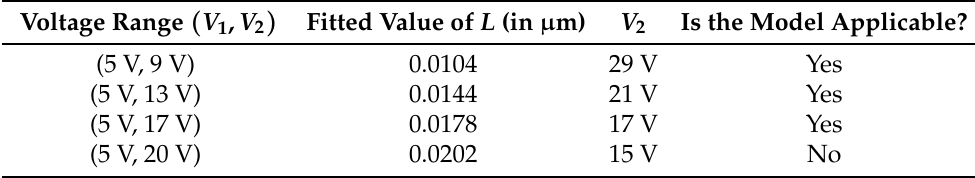
Figure 7. Reduced capacitance curves measured in a planar sample of thickness d = 8.2 µ m at different temperatures. From top to bottom, T = 34,35,36,37,38,39,40 and 40.5 ◦ C. Table 1. Value of L obtained from fitting in the voltage range ( V 1 , V 2 )